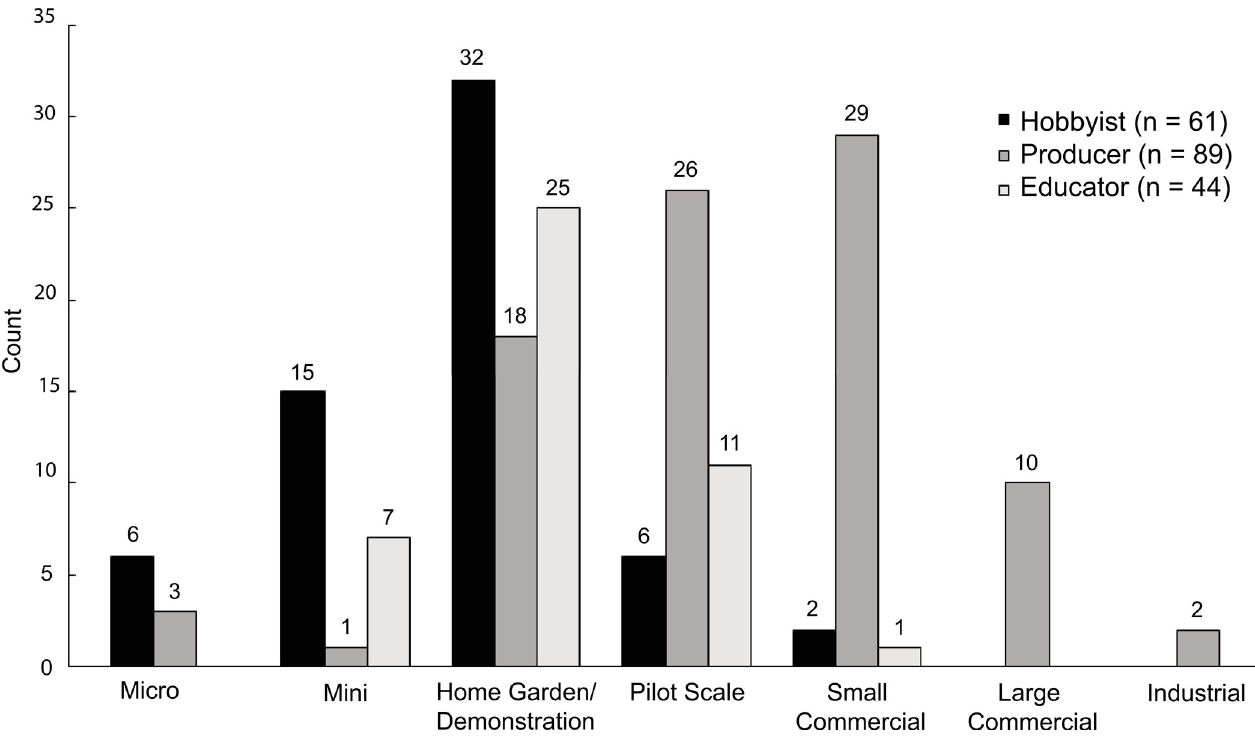
Fig 4. Size distribution of combined fish and plant area footprint of hobbyist, producer, and educator aquaponic systems. Numbers above bars represent the number of respondents. Size designations are ‘micro’ = < 10 ft 2 ; ‘mini’ = 10 to 50 ft 2 ; ‘home garden/demonstration’ = 50 to 500 ft 2 ; ‘pilot scale’ = 500 to 3,000 ft 2 ; ‘small commercial’ = 3,000 to 22,500 ft 2 ; ‘large commercial’ = 22,500 to 165,000 ft 2 ; ‘industrial’ = > 165,000 ft 2 .